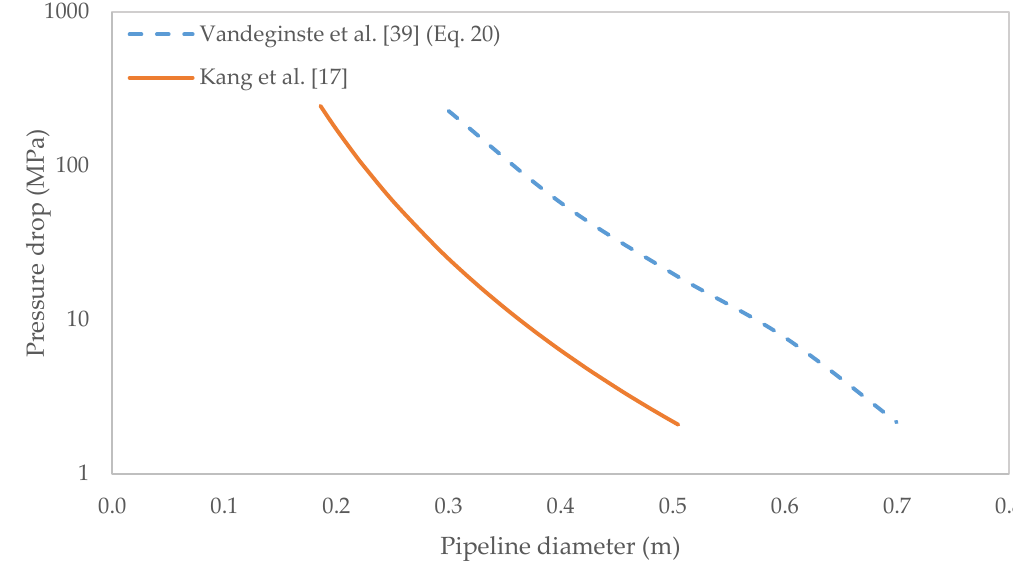
Figure 6. Effect of pipeline diameter on pressure drop for 479 km long pipeline. (Adapted from Kang et al. [17] and Vandeginste et al. [39]).